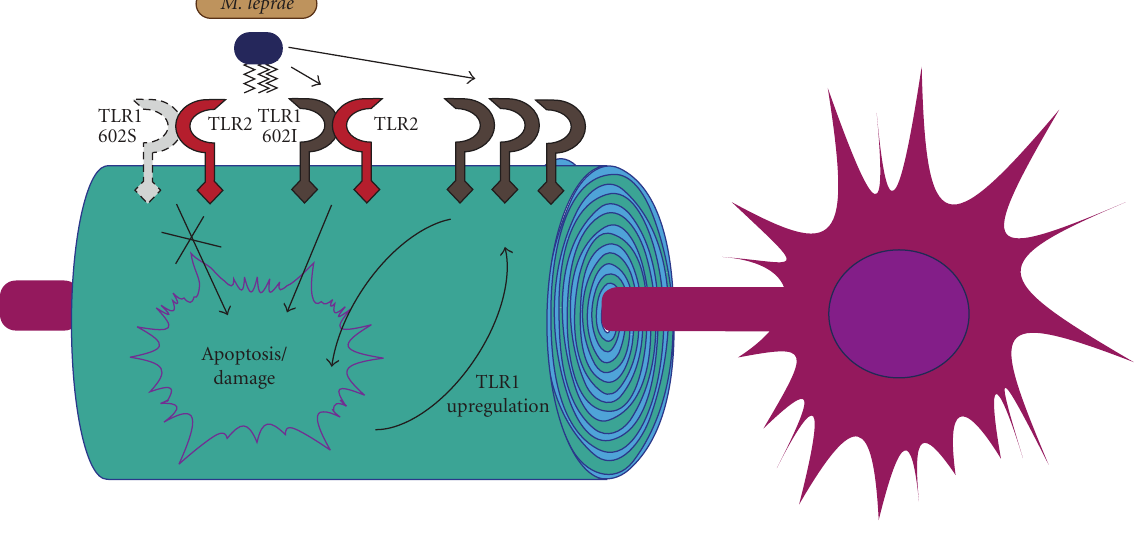
Figure 3: Schwann cells displaying TLR1 602I and TLR2 are stimulated by the M. leprae 19kDa lipoprotein to commence programmed cell death. Damage to peripheral nerves, by either direct infection or inflammatory ischemia, induces TLR1 expression which, in combination with TLR2 and mycobacterial products, can amplify apoptotic signals. Upregulation of TLR1 from damage caused by either direct infection or inflammatory ischemia could predispose nerves to further injury, resulting in classical leprosy anesthesis. Cells expressing the tra ffi cking- deficient TLR1 602S may resist this mechanism of nerve